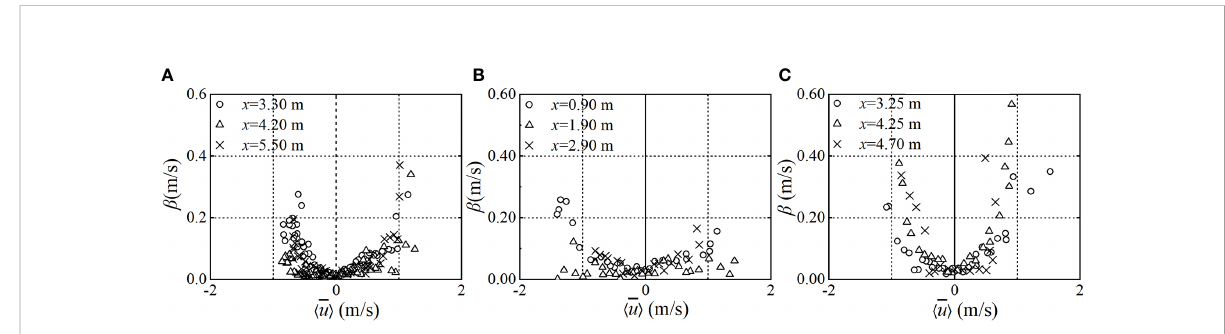
FIGURE 9 A parameter ( b ) to evaluate the degree of depth uniformity of the cross-shore velocity pro fi le: (A) mild beach; (B) steep beach; (C) composite beach.